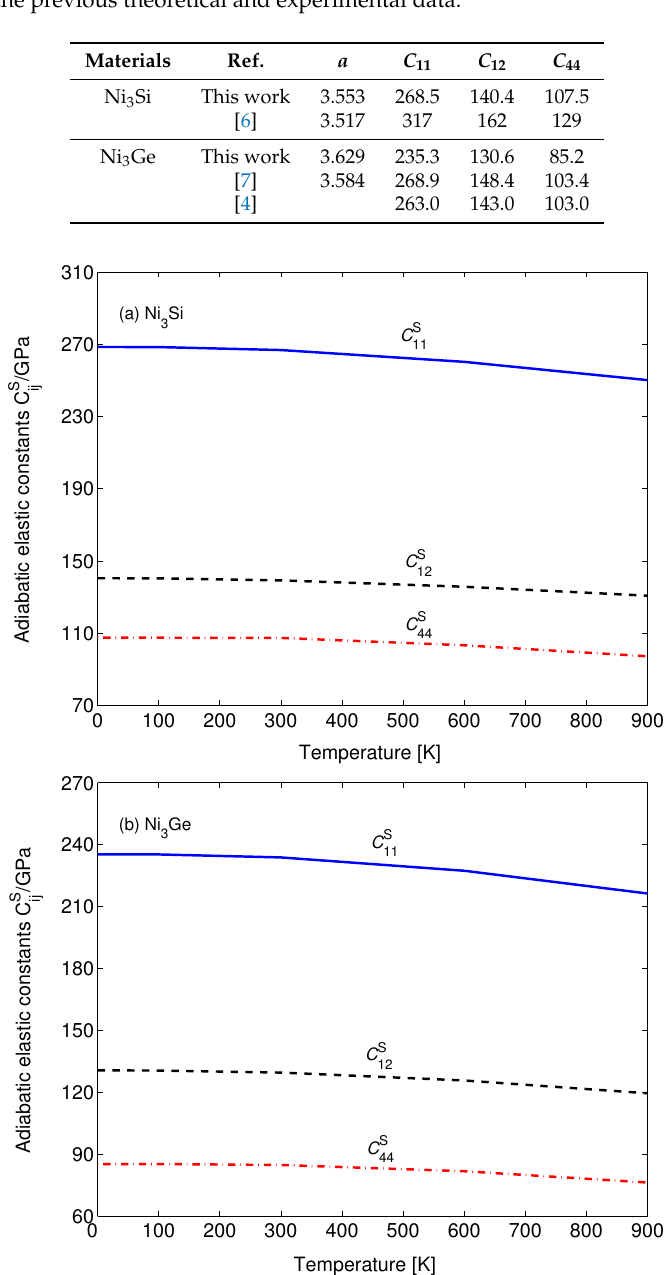
Table 1. Calculated lattice parameter a and elastic constants C 11 , C 12 , C 44 of Ni 3 Si and Ni 3 Ge at 0 K compared with the previous theoretical and experimental data.